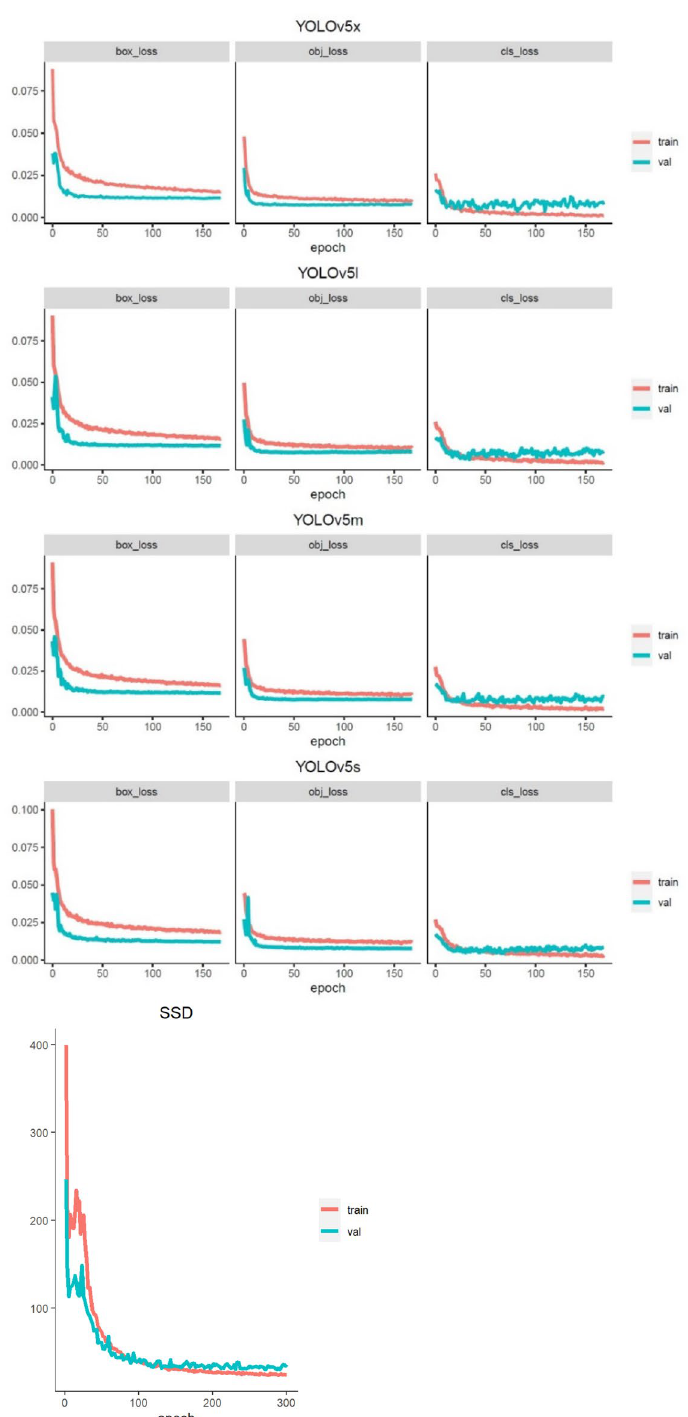
Figure 5. Training and validation curves for the YOLO and SSD models. Box_loss: box loss. Obj_loss: object loss. Cls_loss: class loss. SSD Single shot multi-box detector, YOLO “You Only Look